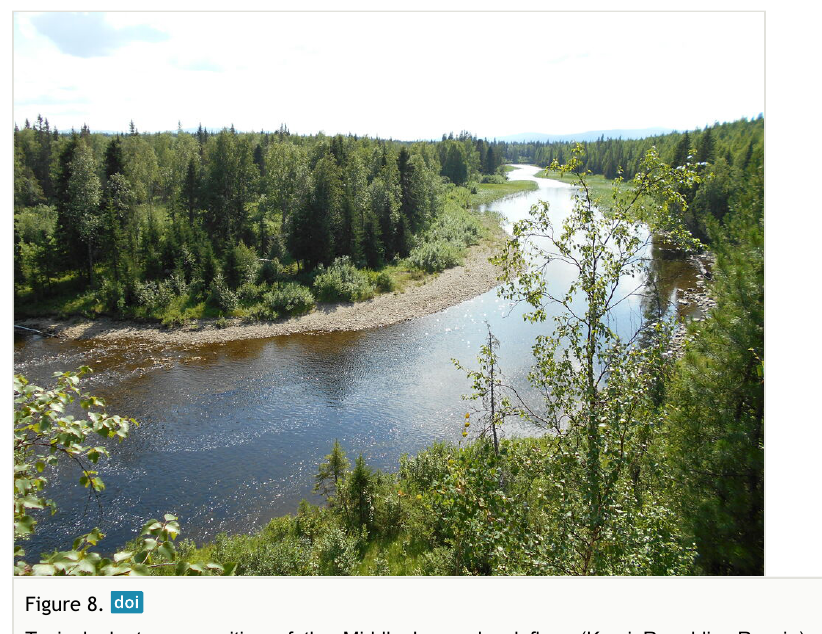
Figure 8. Typical plant communities of the Middle Lyaga local flora (Komi Republic, Russia): river